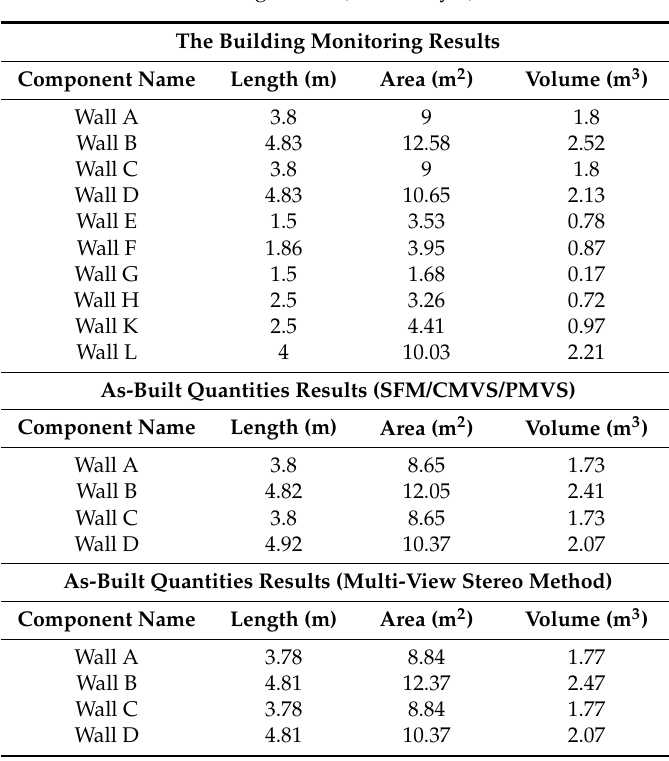
Table 3. The quantities of performed work determined by the proposed photogrammetric Multi-View Stereo method and SFM/CMVS/PMVS algorithm (case study